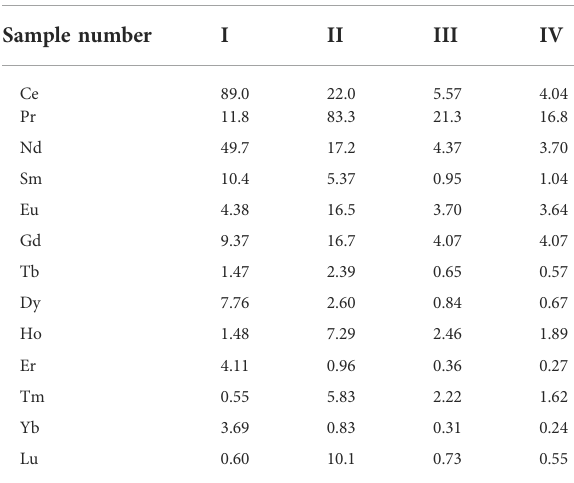
TABLE 1 The chemical composition, trace elements, and REEs of the rock samples in this